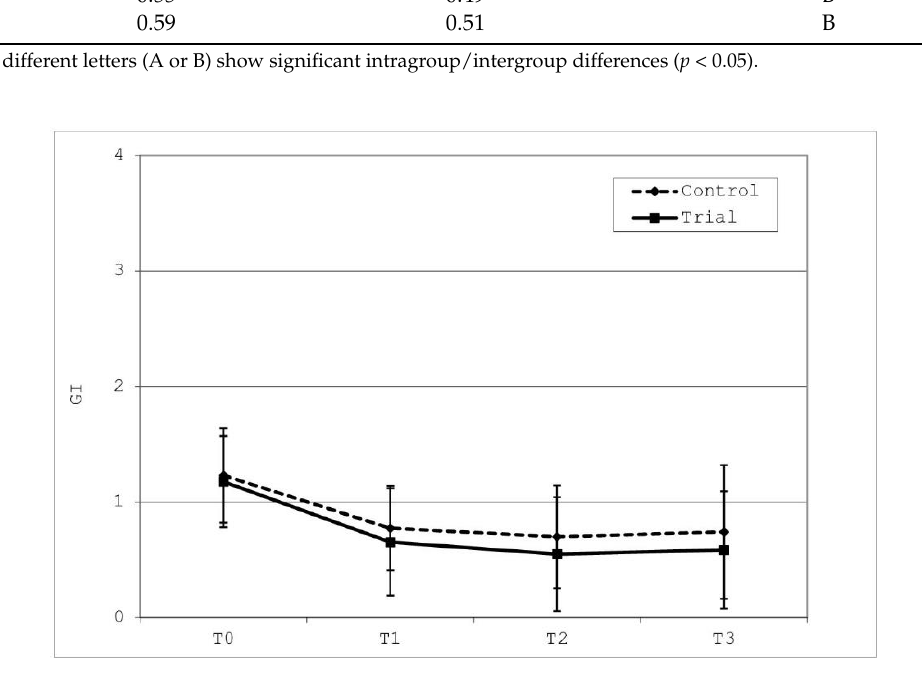
Figure 3. Modified gingival index (MGI). Mean and standard deviation of the MGI in the intervention and control group. Table 3. Descriptive statistics of MGI results. Table 4. Descriptive statistics of PI